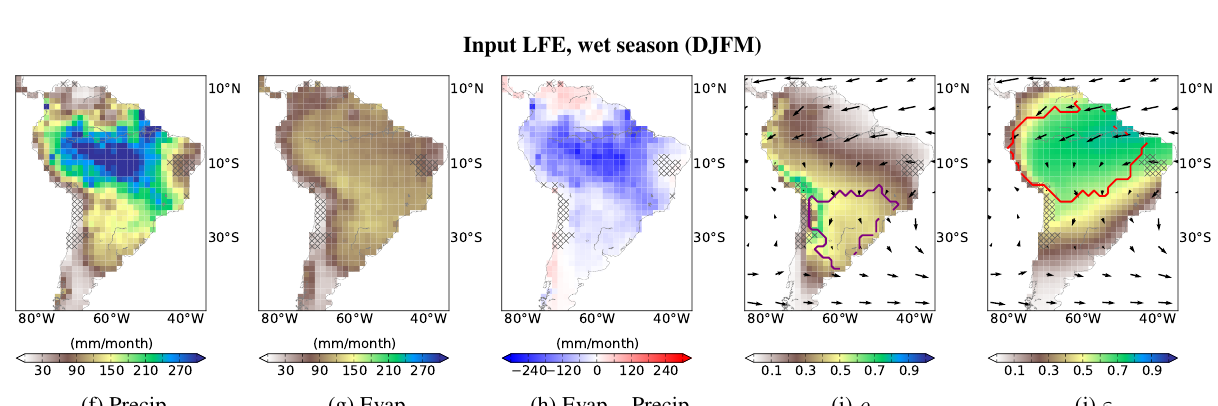
Fig. 3: Schematic representation of the moisture recycling network. The exchange of moisture from 2 towards 4 uses two alternative pathways: the direct one ( m ) and the cascading pathway ( m ). The grid cell 1 is an intermediary on an 24 21 m 14 alternative pathway to the direct transport of moisture between 2 and 4 . Thus, grid cell 1 forms a Middleman motif with grid cells 2 and 4.